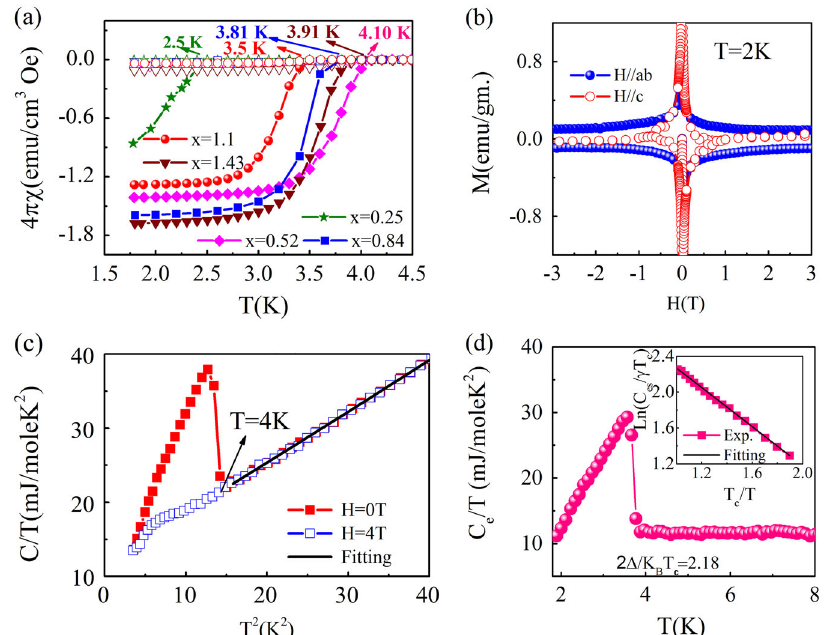
Fig. 3 Magnetic and thermodynamic properties of 2H-TaSe 2 − x S x (0 ≤ × ≤ 2) a Magnetic susceptibility after zero- fi eld-cooling ( fi lled ) and fi eld- cooling (FC, open symbols ). The smaller magnetization value for FC is likely due to the complex magnetic fl ux pinning effects. b Magnetization hysteresis loops M(H) of TaSe 1.48 S 0.52 for H ∥ ab ( solid ) and H ∥ c ( open symbols ). c Low-temperature speci fi c heat of TaSe 1.48 S 0.52 measured at H = 0 ( solid ) and in 4 T ( open symbols ). d The electronic-speci fi c heat in the superconducting state C e for 2H-TaSe 1.48 S 0.52 is obtained by subtracting the lattice contribution from the total speci fi c heat: C e = C − C ph = γ T , where C ph ( T ) = β T 3 + δ T 5 and θ D = [( n ·1.944 × 10 6 )/ β ] 1/3 , where n is the number of elements per formula unit. Inset : below the superconducting transition temperature, electronic-speci fi c heat temperature